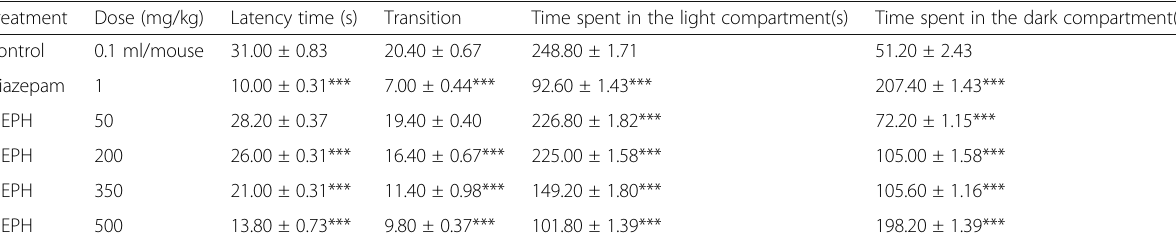
Table 7 The effect of MEPH on light-dark box test in mice